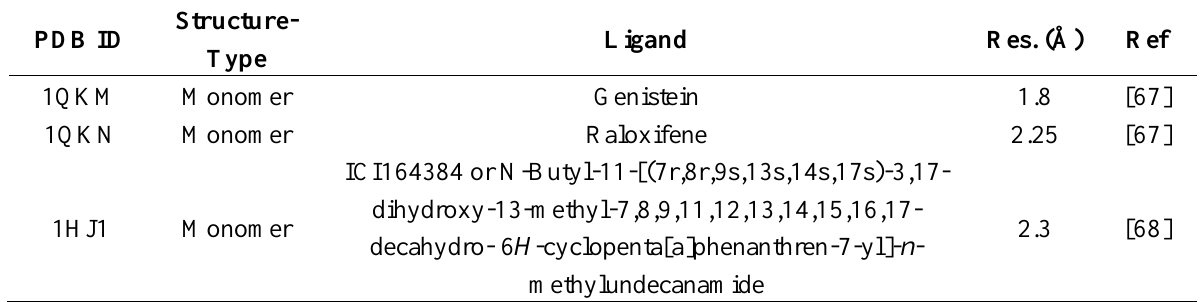
Table 2. Crystal structures of ERβ ligand binding domain bound with ligands in